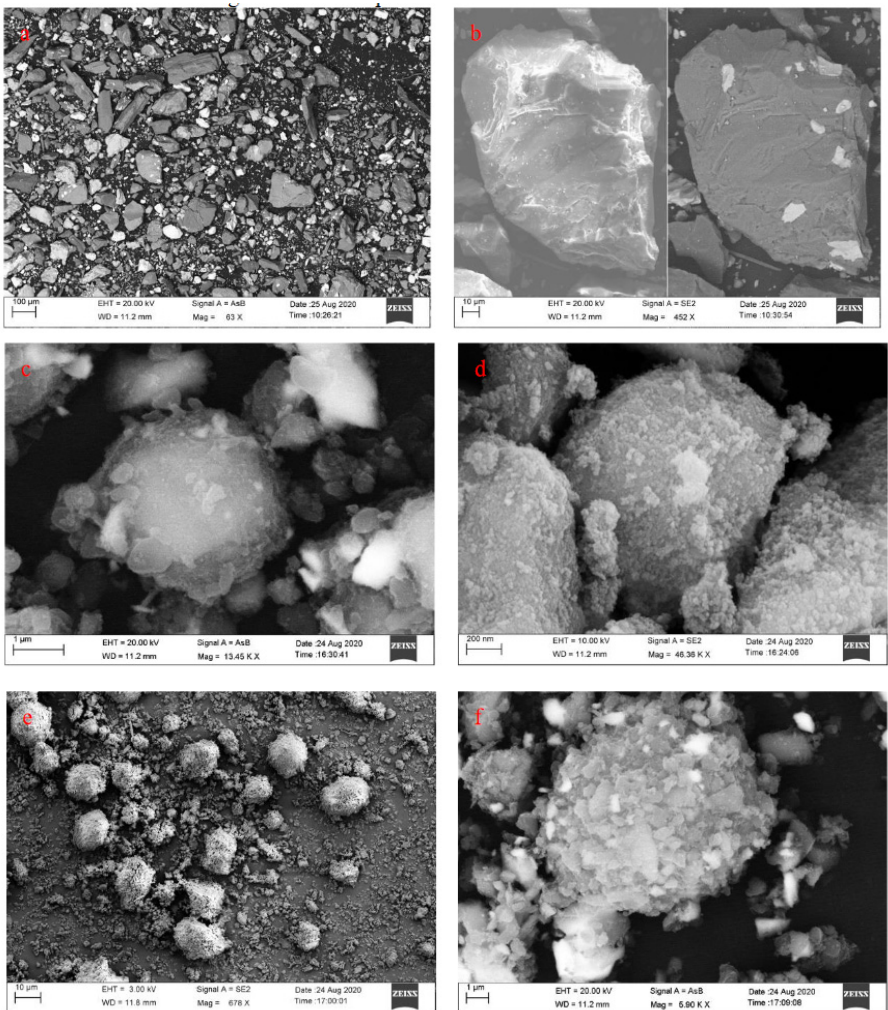
Figure 4. SEM imaging of raw ore, ordinary ball milling mixture and high energy ball milling mixture; ( a ) SEM image of the original tailings; ( b ) comparison of SE 2 and AsB of original tailings; ( c ) the morphology of the catalyst of ordinary ball mill; ( d ) partially enlarged topography of the catalyst surface of ordinary ball milling; ( e ) SEM image of high-energy ball milling catalyst; ( f ) partially enlarged topography of the catalyst surface of high-energy ball milling.